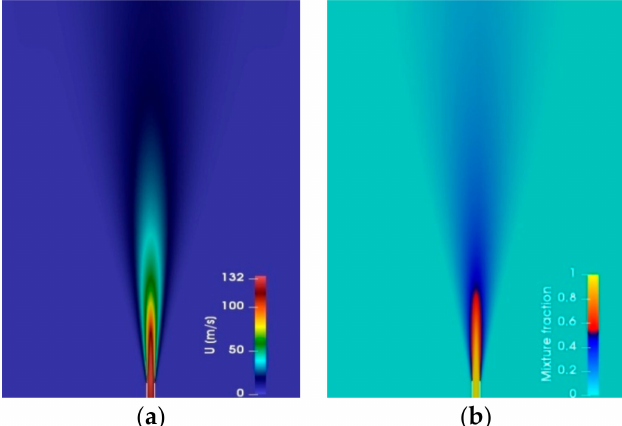
Figure 6. Contour plots from ESF/FPV simulation for Oxyfuel flame B3: ( a ) mean velocity, ( b ) mixture